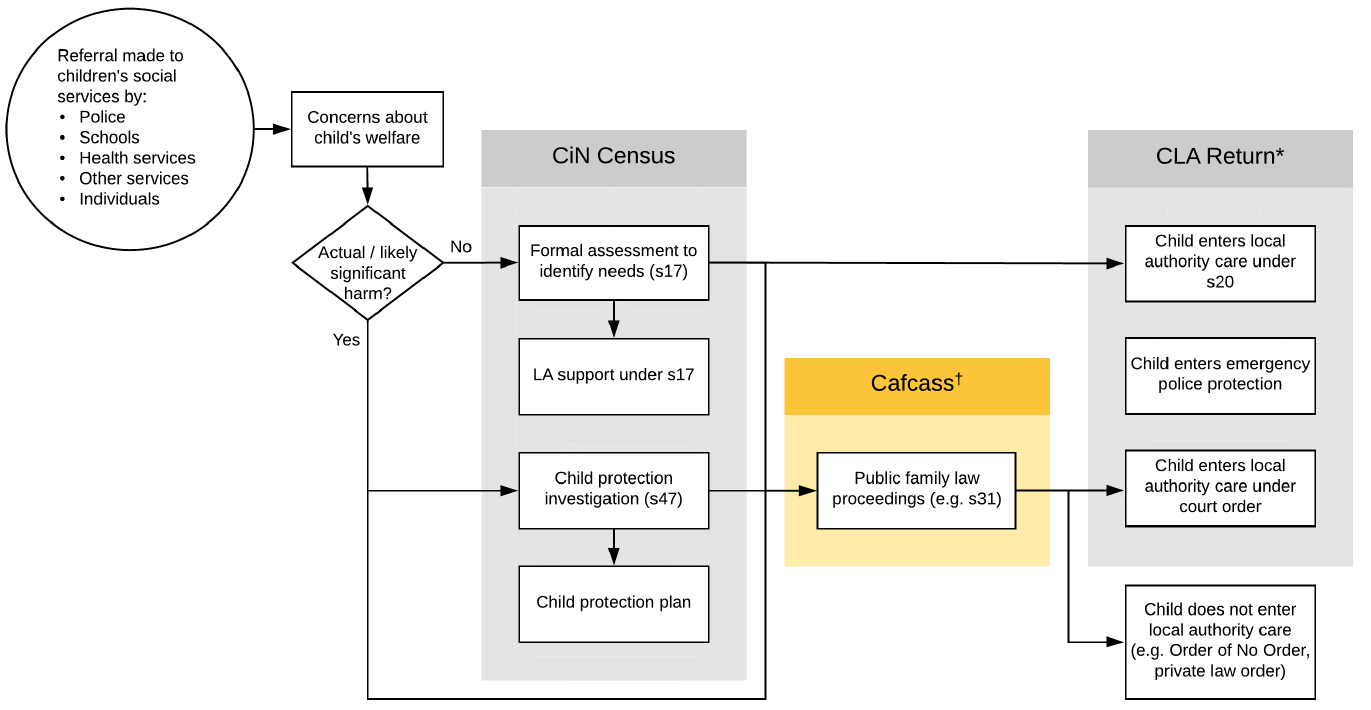
Figure 1: A summary of how the three different national datasets capture children who come into initial contact with children’s services.